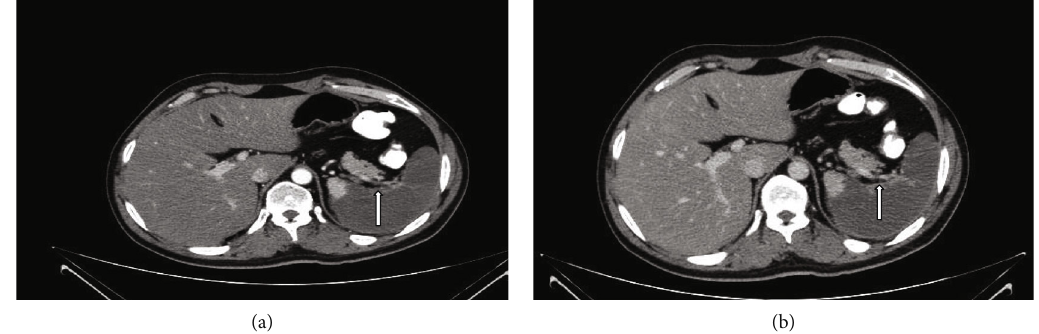
Figure 3: Abdominal CT shows artery occlusion and complete absence of blood circulation on the spleen. White arrow shows the infract after the enhancement of contrast material at the (a) arterial and (b) venous phase.